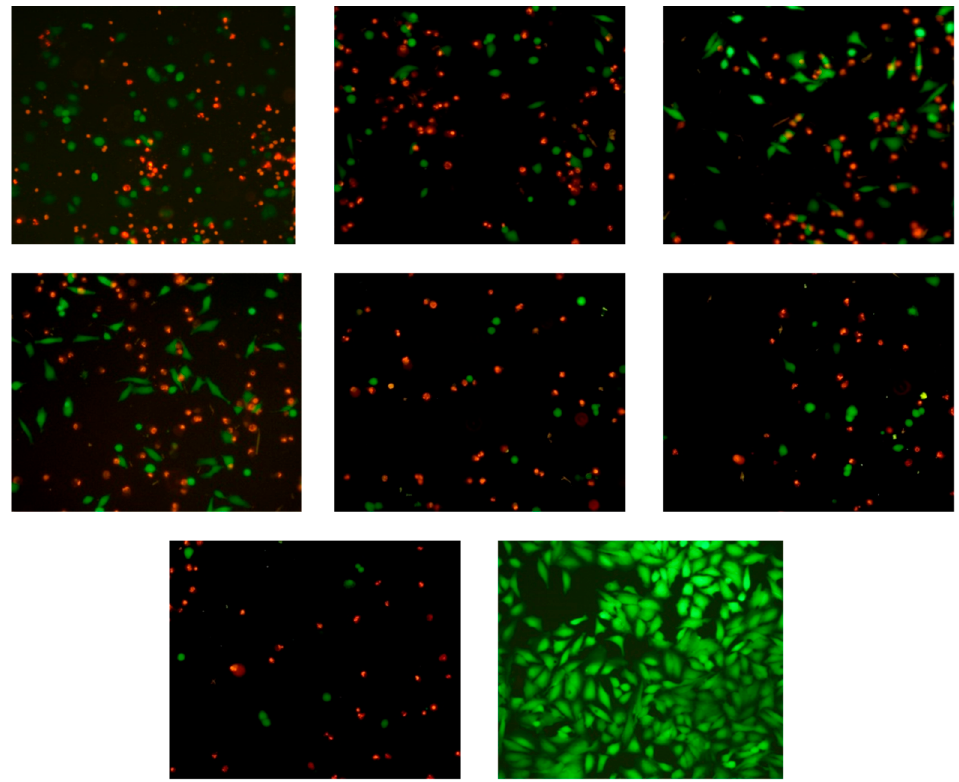
Figure 4. Viability of HeLa cells treated with 1mg/mL of 4a – c , 5a – d for 24 h. FDA/PI staining, 200×.